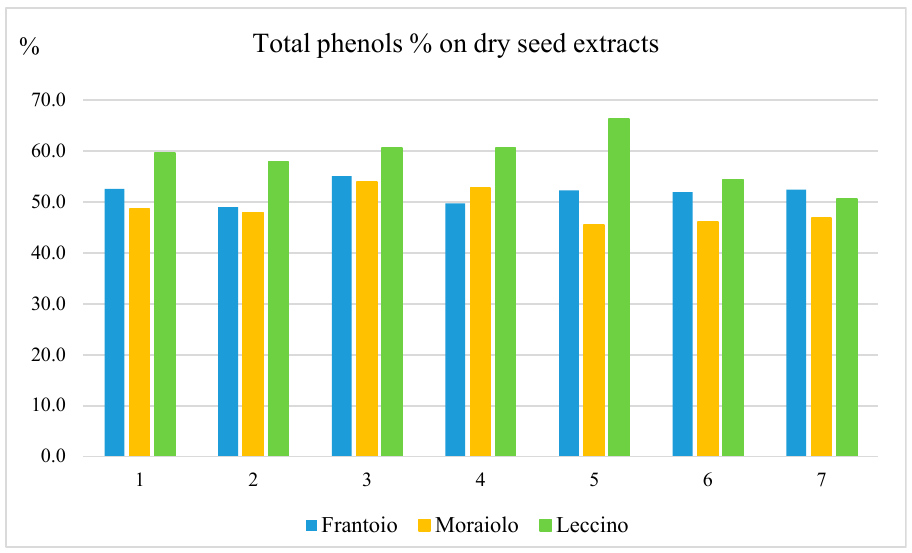
Figure 5. Percentage of total phenols in dry seed extracts for the three cultivars over the course of ripening. In the abscissa, the ripening period is indicated.